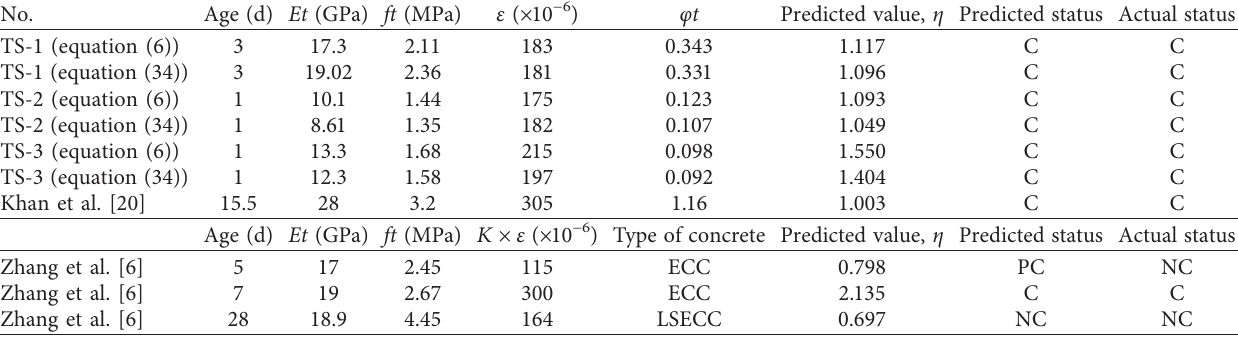
Table 5: Test value and verification of early cracking risk coefficient of